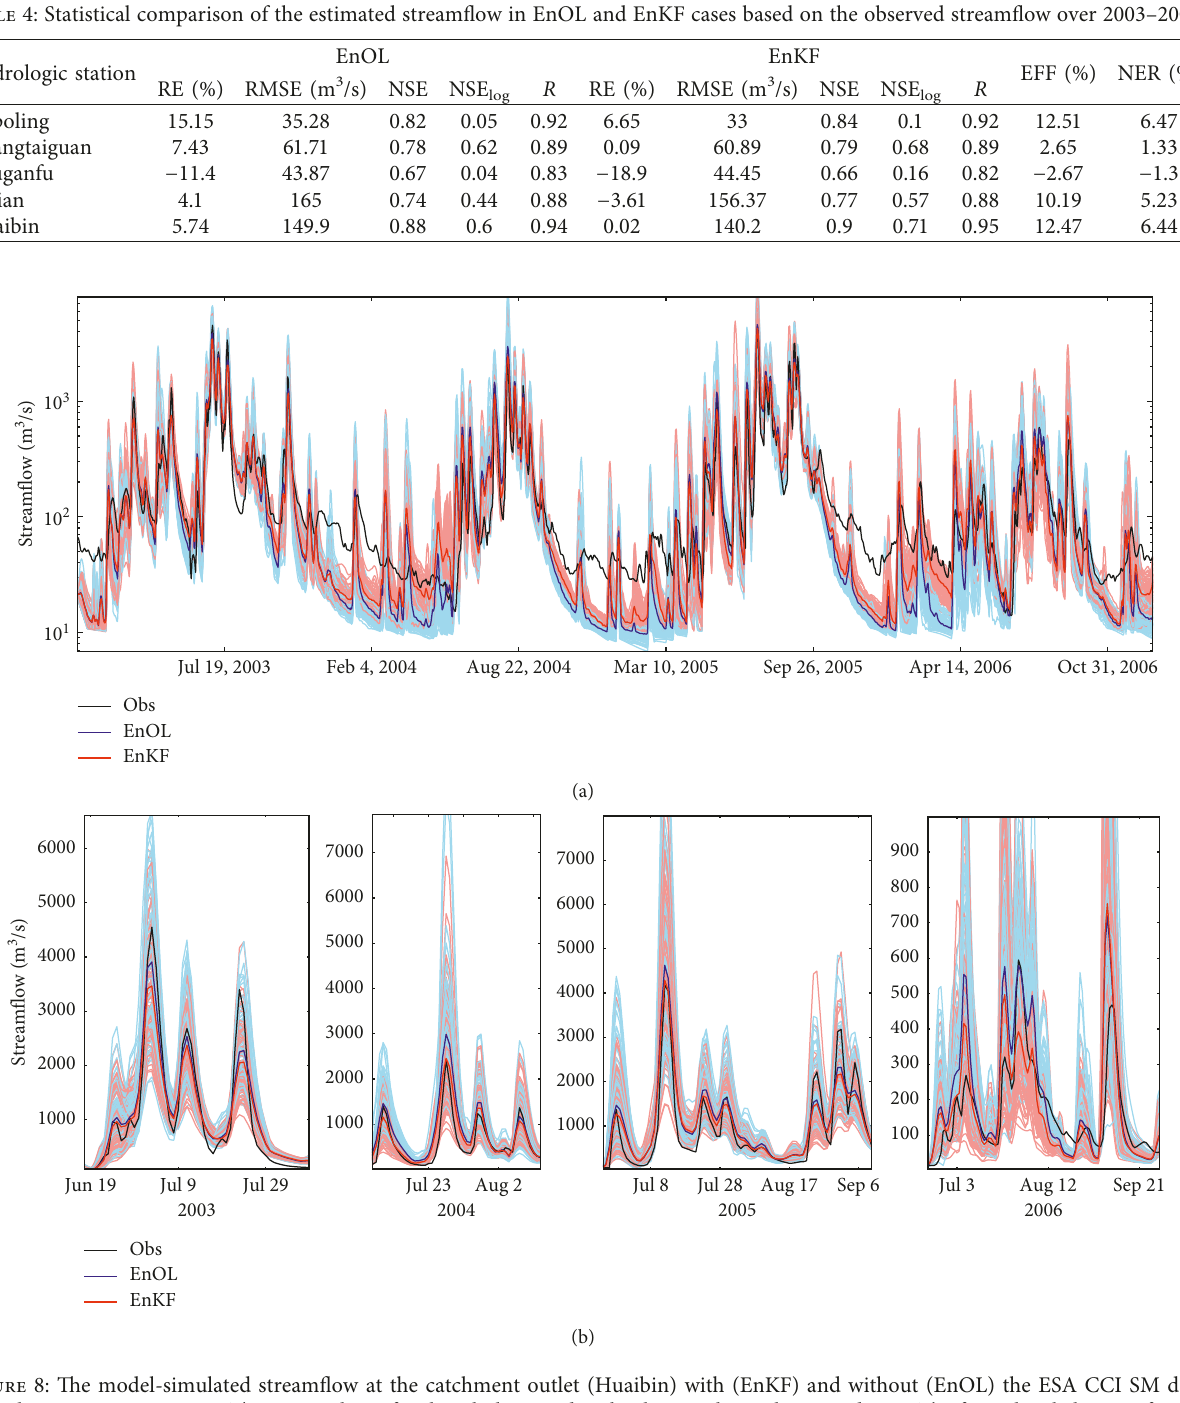
Figure 8: The model-simulated streamflow at the catchment outlet (Huaibin) with (EnKF) and without (EnOL) the ESA CCI SM data assimilation over 2003–2006. The upper plot is for the whole period with a base 10 logarithm coordinate. The four plots below are for the flood season from 2003 to 2006. The red and blue lines are the EnKF and EnOL ensemble members, and the red and blue bold lines represent the mean value of EnKF and EnOL. Obs is the abbreviation of observation.